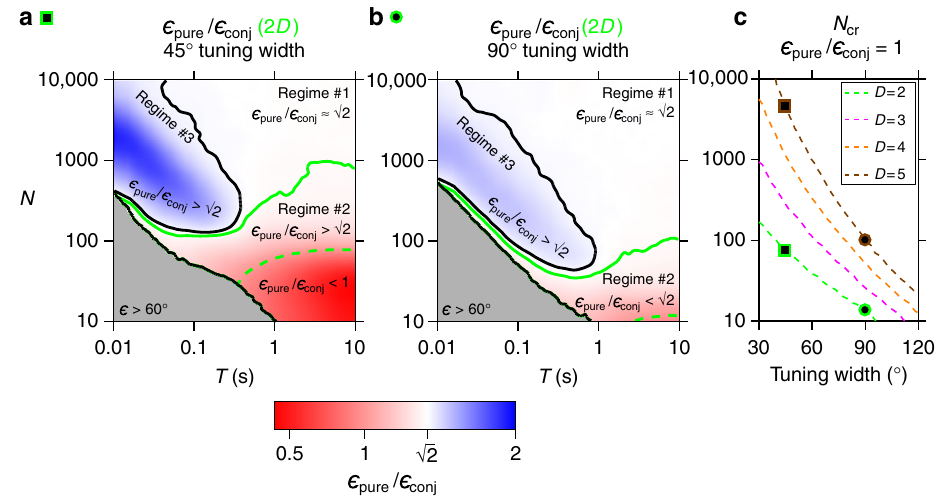
Fig. 3 Relative coding accuracy of pure and conjunctive cells representing a multidimensional variable. a Relative decoding performance of pure versus ffiffiffi p = ϵ ¼ conjunctive cells representing a 2D variable. We identify three regimes: regime #1, where ϵ 2 , as predicted by the Fisher information (FI) pure conj calculation (white area); regime #2, where the relative performance of the pure cell population improves as compared to regime #1; and regime #3 (blue), ffiffiffi p (cid:3) (cid:4) = ϵ . When the number of neurons is moderate (regime where the conjunctive cells outperform the pure cells even beyond the FI calculation ϵ 2 pure conj > #2) we fi nd a speci fi c subregion below a critical value of N (dashed line), for which the pure cells start to outperform the conjunctive cells also in absolute . b Same as ( a ) computed for neurons with a wider tuning curve (90° width at half-height). The color bar (bottom) indicates the error ratio between pure and conjunctive cells for a 2D stimulus. c The critical value of N , denoted N cr , is de fi ned to be the population size for which the pure and conjunctive populations have the same average errors at a long decoding time, T = 10s (i.e., for N < N cr . pure cells outperform the conjunctive cells in absolute value, corresponding to the dashed lines in a , b ). Shown is N cr ( y -axis) for different stimulus dimensions D , as function of the tuning width. N cr becomes larger for narrower tuning and for higher dimensionality of the stimulus. Together, this supports the notion that in regime #2 the performance of the conjunctive population is degraded due to loss of coverage of the stimulus space by the available N neurons — which can happen either due to narrower tuning or due to higher dimensionality of the stimulus space. Green square and circle corresponds to the tuning widths (at 2D) for which we plot the error ratio in N − T space ( a , b ). Brown symbols correspond to the plots in 5D (Supplementary Fig.